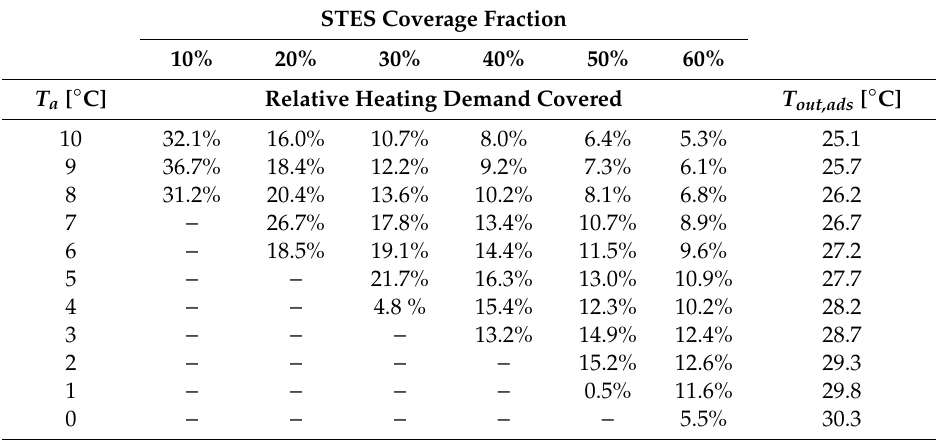
Table 1. Analysis of the heating distribution as a function of the expected seasonal thermal energy storage (STES) coverage fraction, for Stockholm. The table also reports the ambient temperature and the relative supply temperature needed by the floor heating system.